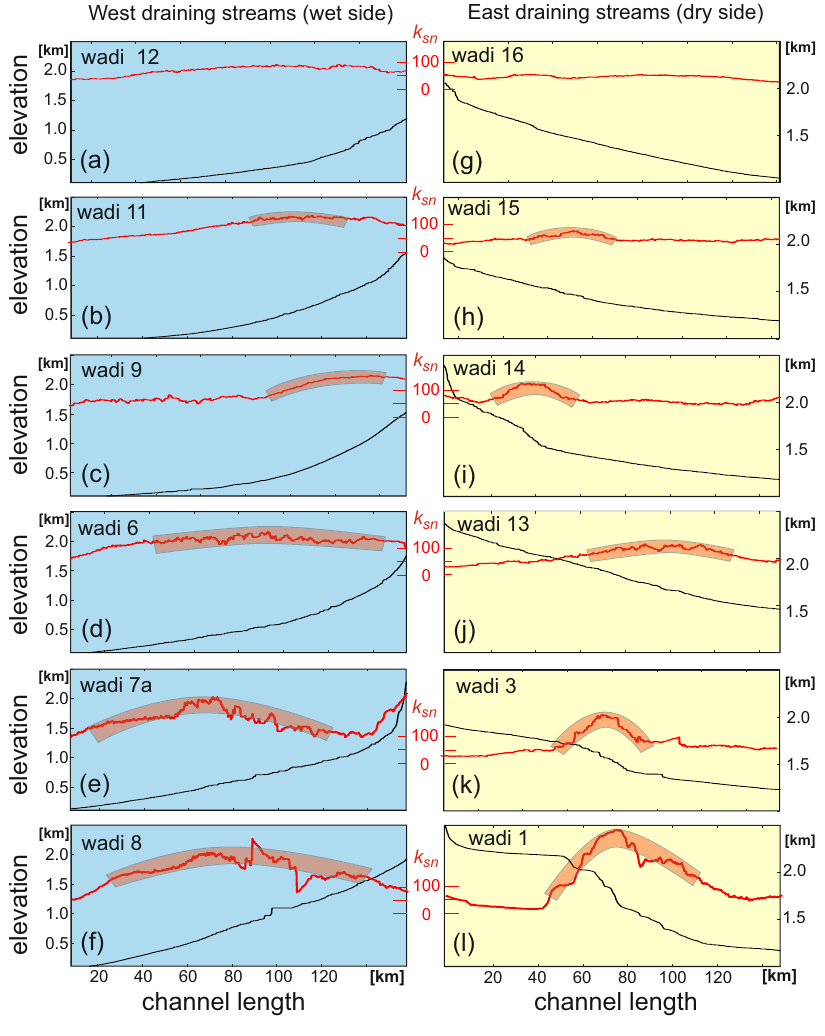
Fig. 2 | Channelpro fi les ofwadis along the SaudiArabianRed Sea margin. Blue for west draining streams (wet side), yellow for east draining streams (dry side). Note that due to the sinuosity of wadis, the distance along the channels does not necessarly corresponds to the distancefrom the coastal margin. Location of wadis is shown in Fig. 1b and is generally from north (at top) to south (at bottom). Red